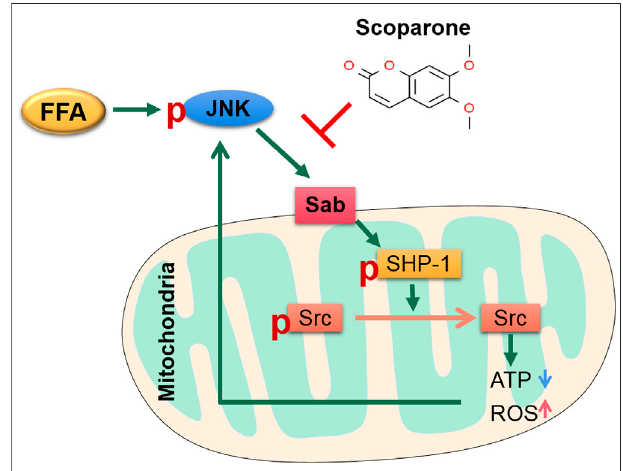
FIGURE9| ThesketchofthemechanismofJNK/Sabsignalingpathway involved in mitochondrial dysfunction in NASH and the effect of Scoparone. Stimulated by free fatty acids, JNK is activated and binds to the outer mitochondrial transmembrane protein Sab, which then releases and promotes the activation of SHP-1 in mitochondria. Phosphorylated SHP-1 could induce the inactivation of Src, which leads to damage of mitochondrial electron transport chain, thereby reducing ATP production and increasing ROS generation. The mitochondrial damage in turn stimulates JNK and thus results in sustained activation of JNK. Scoparone can reverse this process partly through inhibiting the JNK/Sab